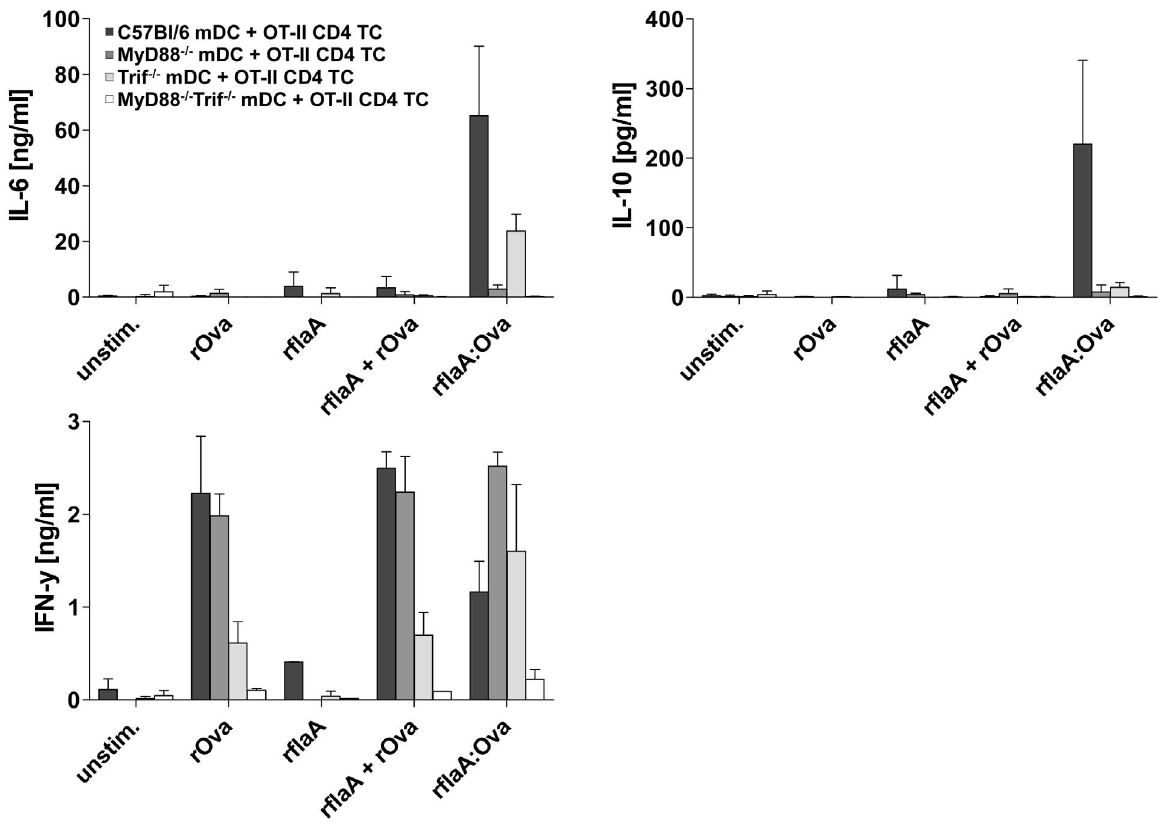
Figure 8. rflaA:Ova-induced IL-6 and IL-10 secretion from mDC are mediated by different signaling pathways. C57BL/6 mDC derived from C57BL/6 wt, MyD88 2 / 2 , Trif 2 / 2 , or MyD88 2 / 2 Trif 2 / 2 mice were co-cultured with OT-II CD4 + T cells and stimulated with equimolar amounts of rOva, rflaA, rflaA + rOva, or rflaA:Ova, respectively. Levels of IL-6, IL-10, and IFN-y in the culture supernatants were analyzed after 72 h. Results are means 6 SD of two independent experiments. Please note that results from C57BL/6 and Myd88 2 / 2 cells were already published in Schu¨lke et al. ,